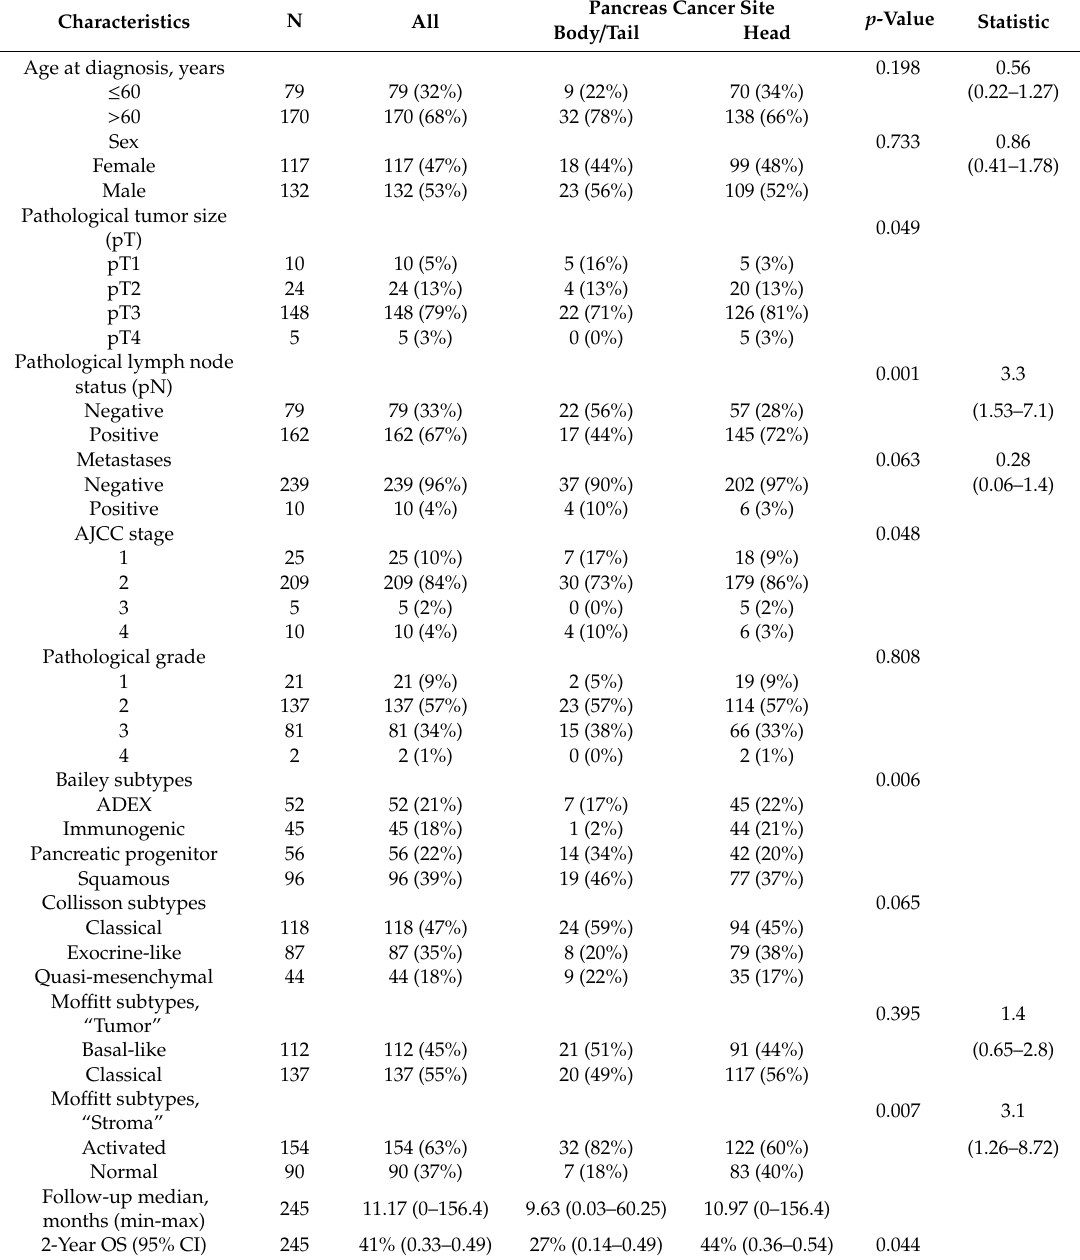
Table 1. Clinicopathological and molecular characteristics of patients in the whole population and in each location